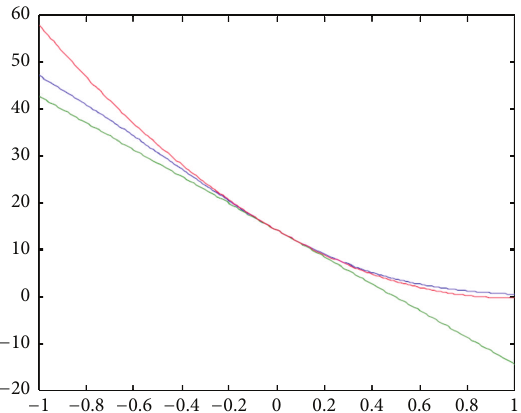
Figure 1: Approximations of the conditional price based on Taylor polynomials using the benchmark set of parameters. The blue line describes the conditional price on [−1,1] while the green and red lines show first- and second-order expansions,